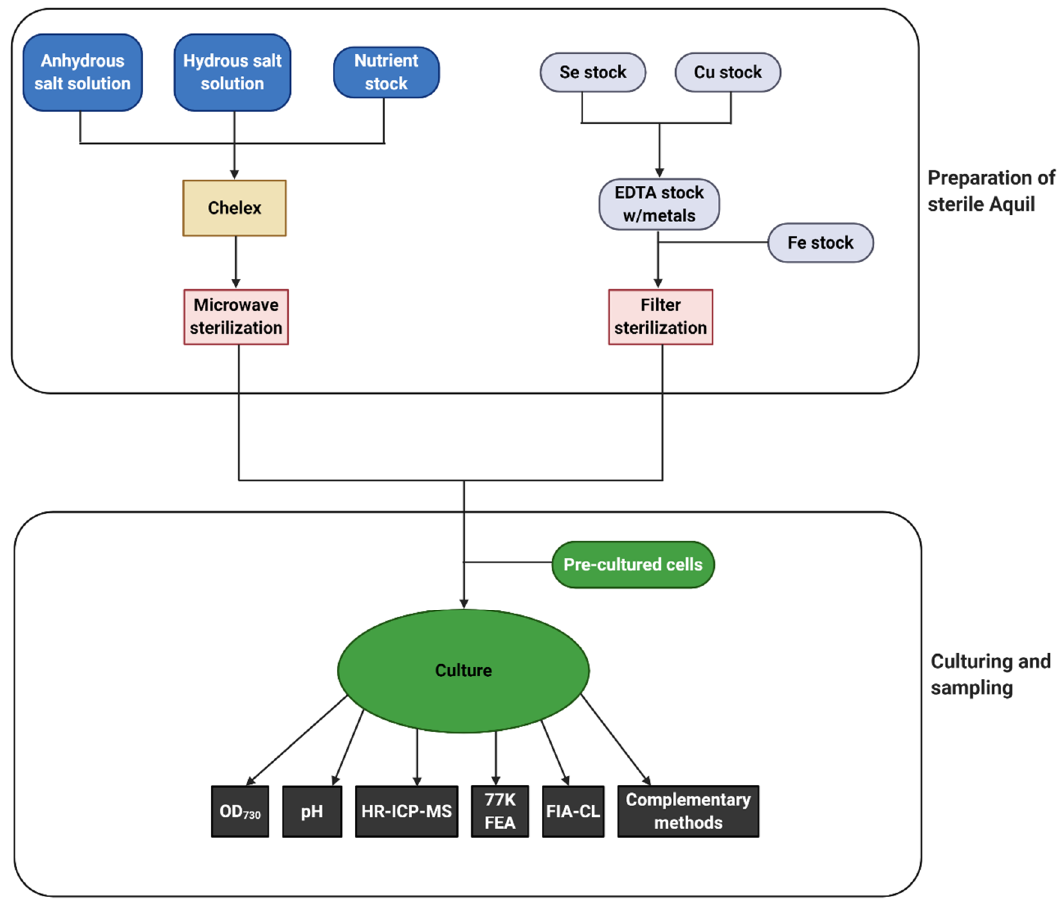
Figure 3. Workflow for a typical iron limitation experiment using Aquil. The workflow is split into two distinctive parts. Preparation of sterile and trace-metal free Aquil includes the preparation of several stock solutions for, e.g., copper and selenium as individual metal stocks, before sterilization and subsequent addition to a final medium. Daily sampling of biological parameters such as the OD 730 , pH, and 77K Fluorescence emission analysis (indicated as 77K FEA) are strongly recommended. Inductively coupled plasma mass spectrometry (indicated as HR-ICP-MS) and Flow Injection Analysis (indicated as FIA-CL) should be sampled according to a carefully considered sampling scheme, taking into consideration the length of the experiment as well as the density and health of the culture. An example of a full sampling procedure including all protocols can be found in the supplementary material.